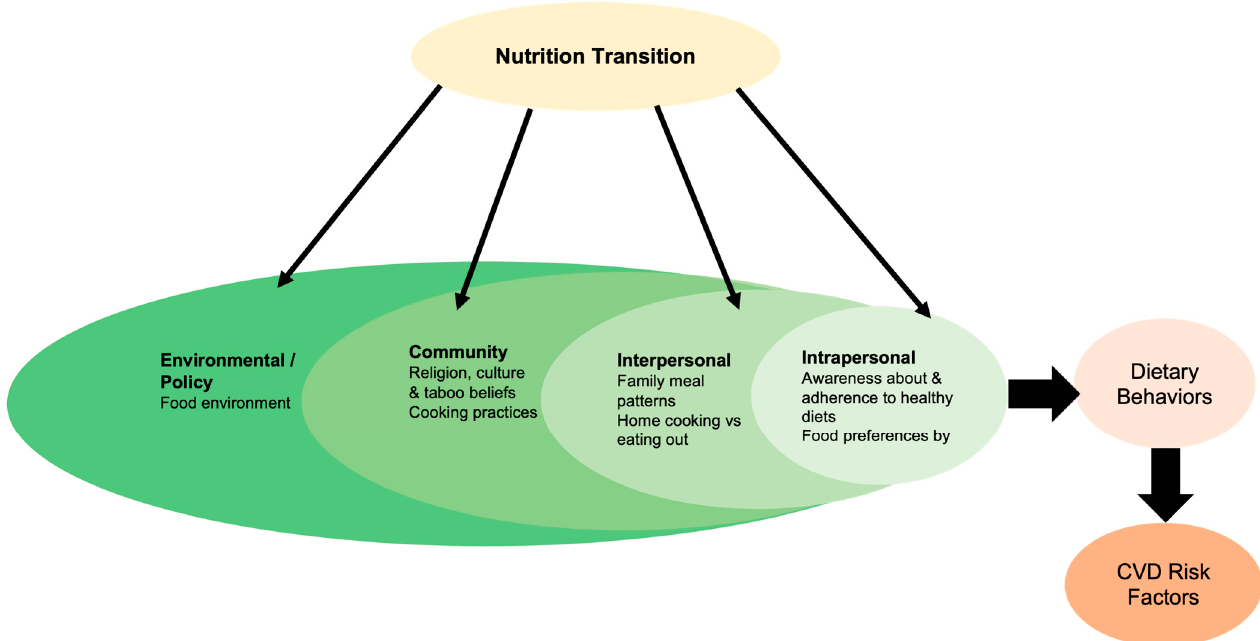
Figure 1. Socio-ecological model of the impacts of nutrition transition on dietary behaviors and CVD risk factors in Indonesia.